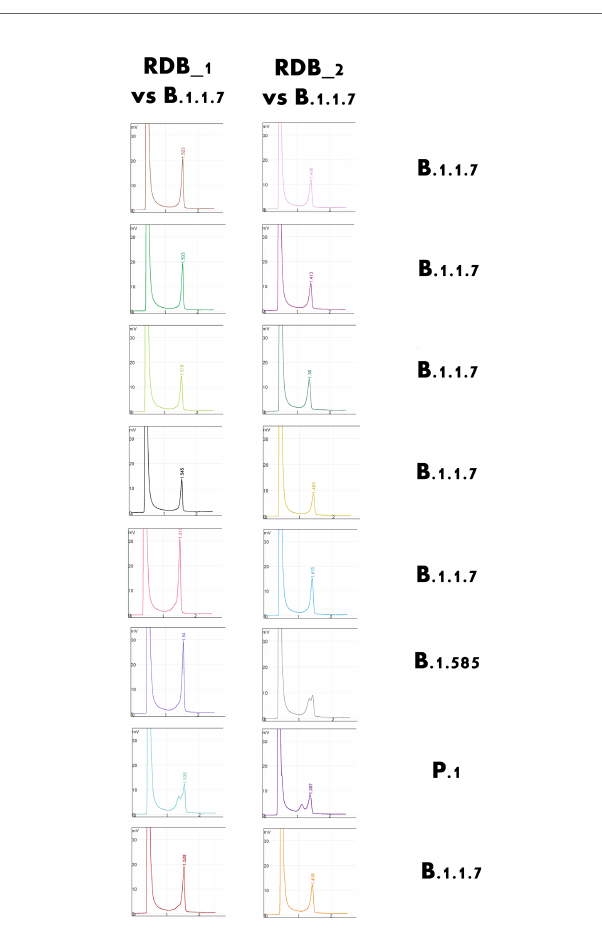
FIGURE 4 | Selected example of the detection of rare variants of concern using the Denaturing High-Performance Liquid Chromatography system. Using the B.1.1.7 strain as a standard, the rarer B.1.585 (Nigerian) and P.1. (Brazilian) variants could be detected and con fi rmed.